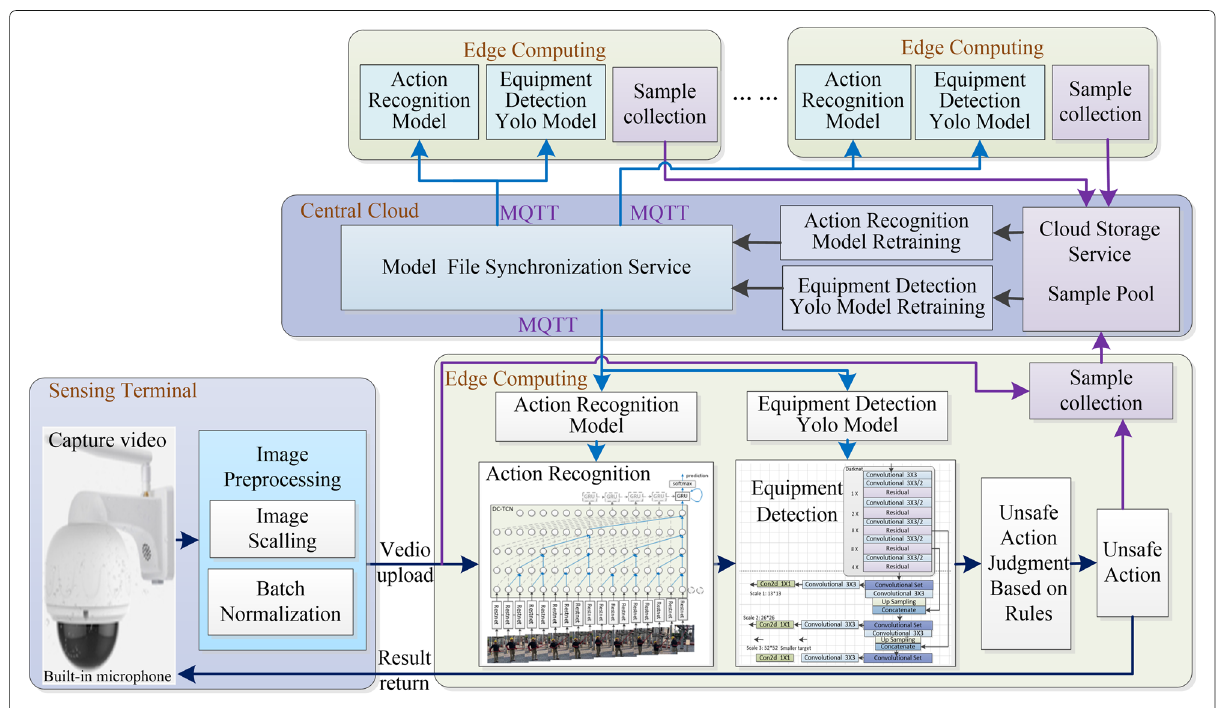
Fig. 4 The working principle framework of the whole system